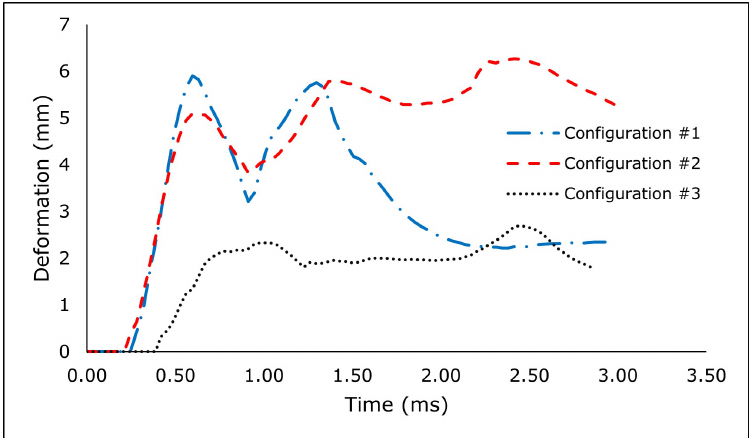
Figure 16. Deformation Curve of The Battery for Each Lattice